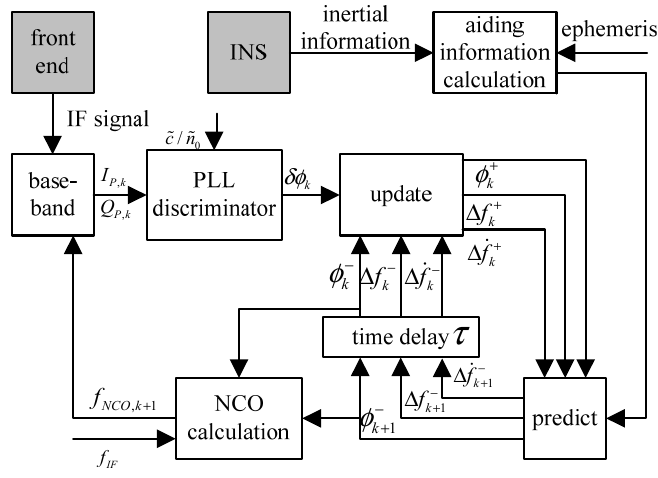
Figure 1. Inertial aided PLL in Compass/INS integrated navigation